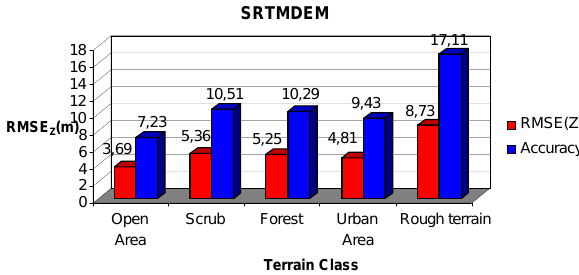
Figure 7. SRTM DEM analysis according to the